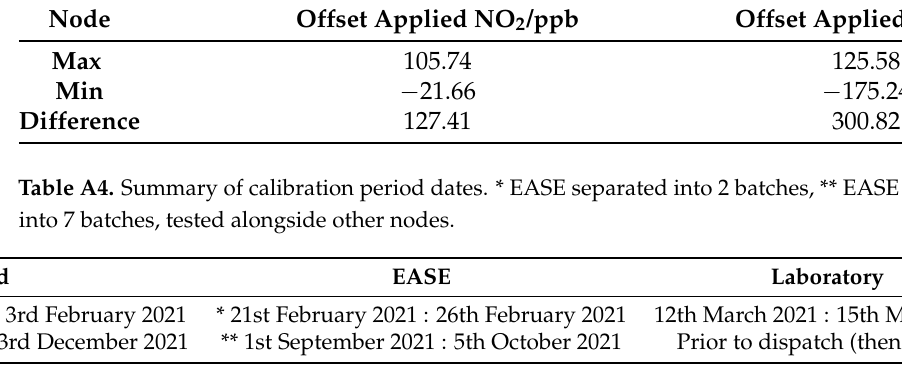
Table A5. Evaluation statistics for training of the MOx nodes with all of the calibration methods. All values are means over all MOx nodes with their corresponding standard deviation shown in brackets.